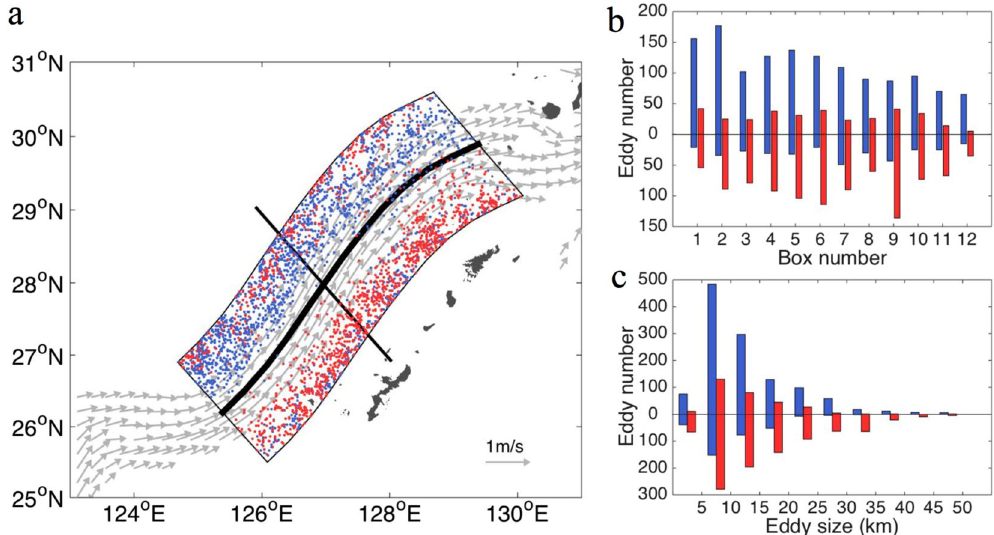
Figure 3. ( a ) Distribution of eddies detected from high-resolution model using Necioli et al .’s 12 eddy detection scheme. Blue and red dots denote cyclonic and anticyclonic eddies, respectively. The Kuroshio velocity with the speed of larger than 40 cm/s is shown by the grey arrows. The climatological Kuroshio axis (thick black line) was determined by the maximum speed. The black line perpendicular to the Kuroshio axis is used for deriving horizontal current profiles along the direction of the Kuroshio axis. ( b ) Eddy number within each bin in Fig. 2. Same as Fig. 2, except for eddies detected from high resolution model outputs. ( c ) Eddy size histogram. Figures are plotted using MATLAB R2014b (http://www.mathworks.com/) with M_Map (a mapping package, http:// www.eos.ubc.ca/~rich/map.html).